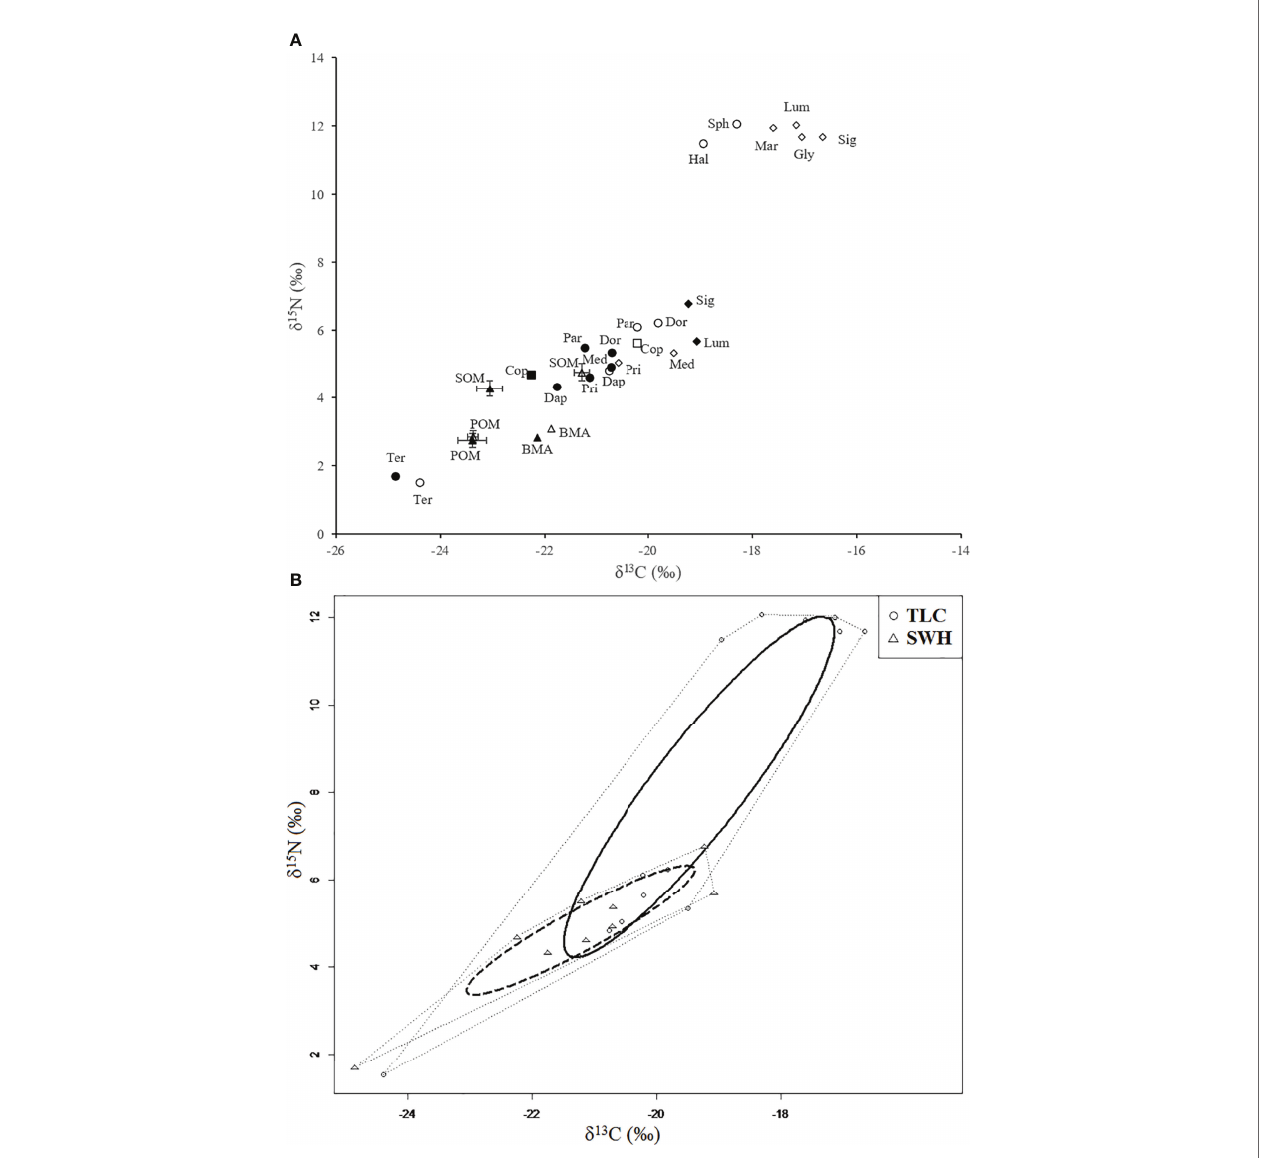
FIGURE 2 | Stable isotope food web bi-plot for (A) all consumers and potential food sources at TLC (open symbols) and SWH (solid symbols). Each symbol represents the d 13 C and d 15 N values for nematodes (circles), copepods (squares), polychaetes (diamonds) and primary producers (triangles). Cop, Copepods; Dap, Daptonema sp.; Dor, Dorylaimopsis sp.; Gly, Glycera sp.; Hal, Halichoanolaimus sp.; Lum, Lumbrineris sp.; Mar, Marphysa stragulum ; Med, Mediomastus sp.; Par, Paradontophora sp.; Pri, Prionospio sp.; Sig, Sigambra hanaokai ; Sph, Sphaerolaimus sp.; Ter, Terschellingia sp.; (B) convex hull areas (thin dotted lines) and corrected standard ellipses areas (SEAc: bold lines) in the isotopic space for benthic communities sampled at the relatively unpolluted site TLC (circle) and organically enriched site SWH